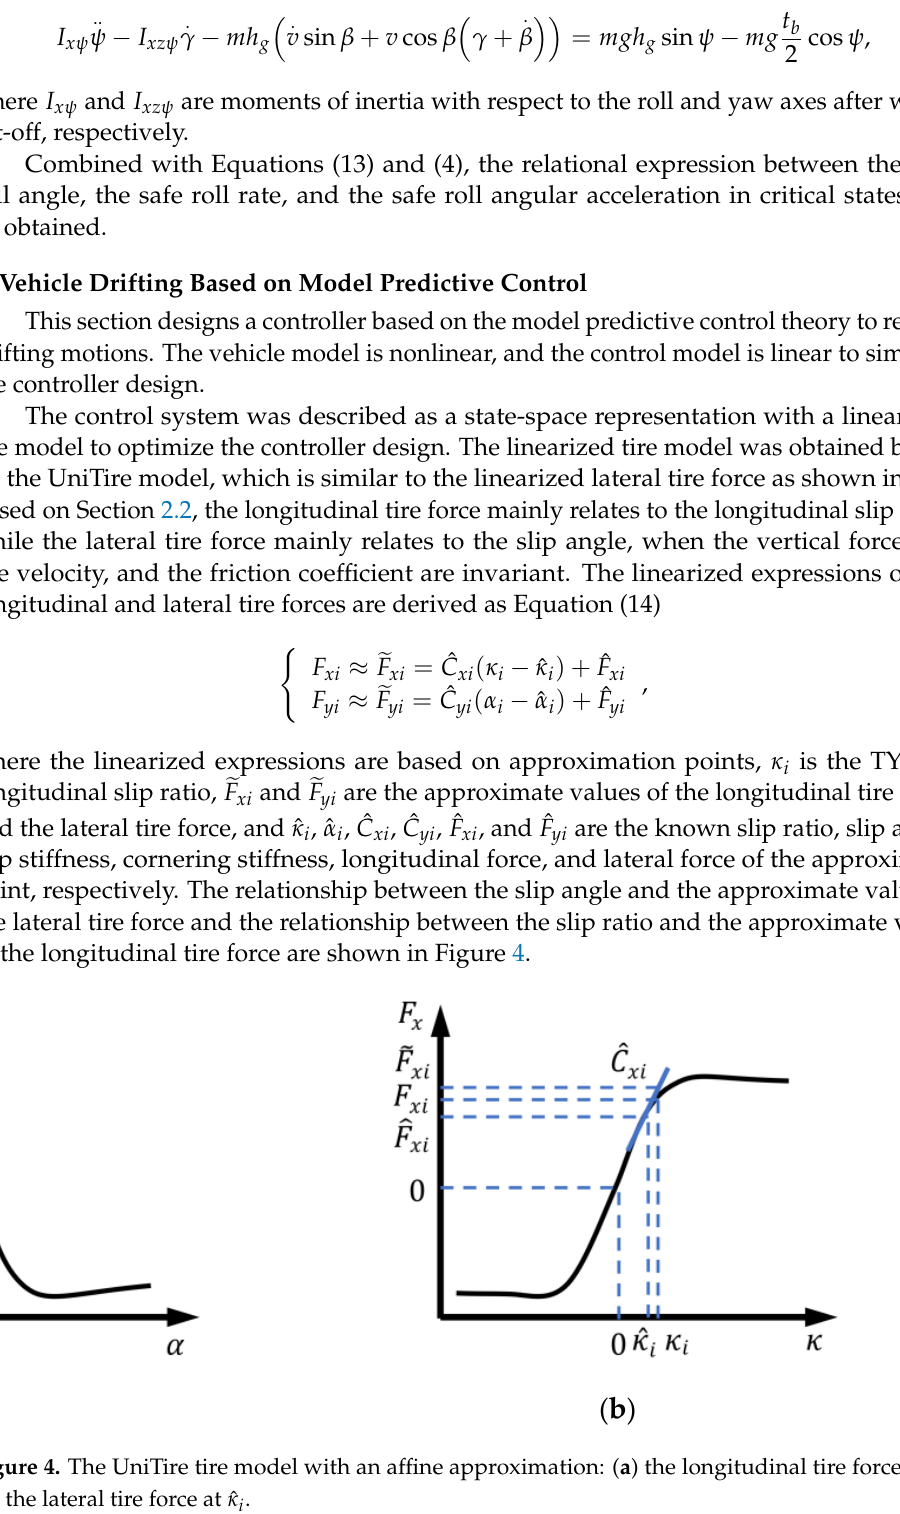
( b ) the lateral tire force at 𝜅̂